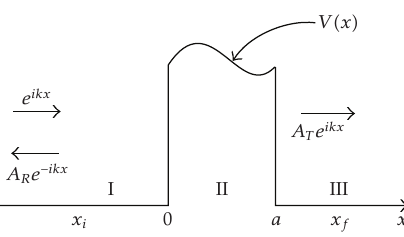
Figure 2: Schematic view of particle scattering and tunneling through a potential barrier.